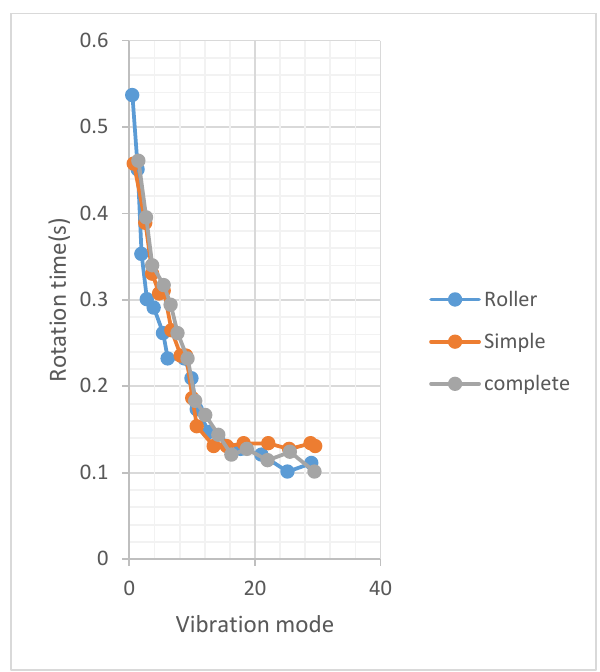
Fig. 8. Five- span bridge with a base height of 6